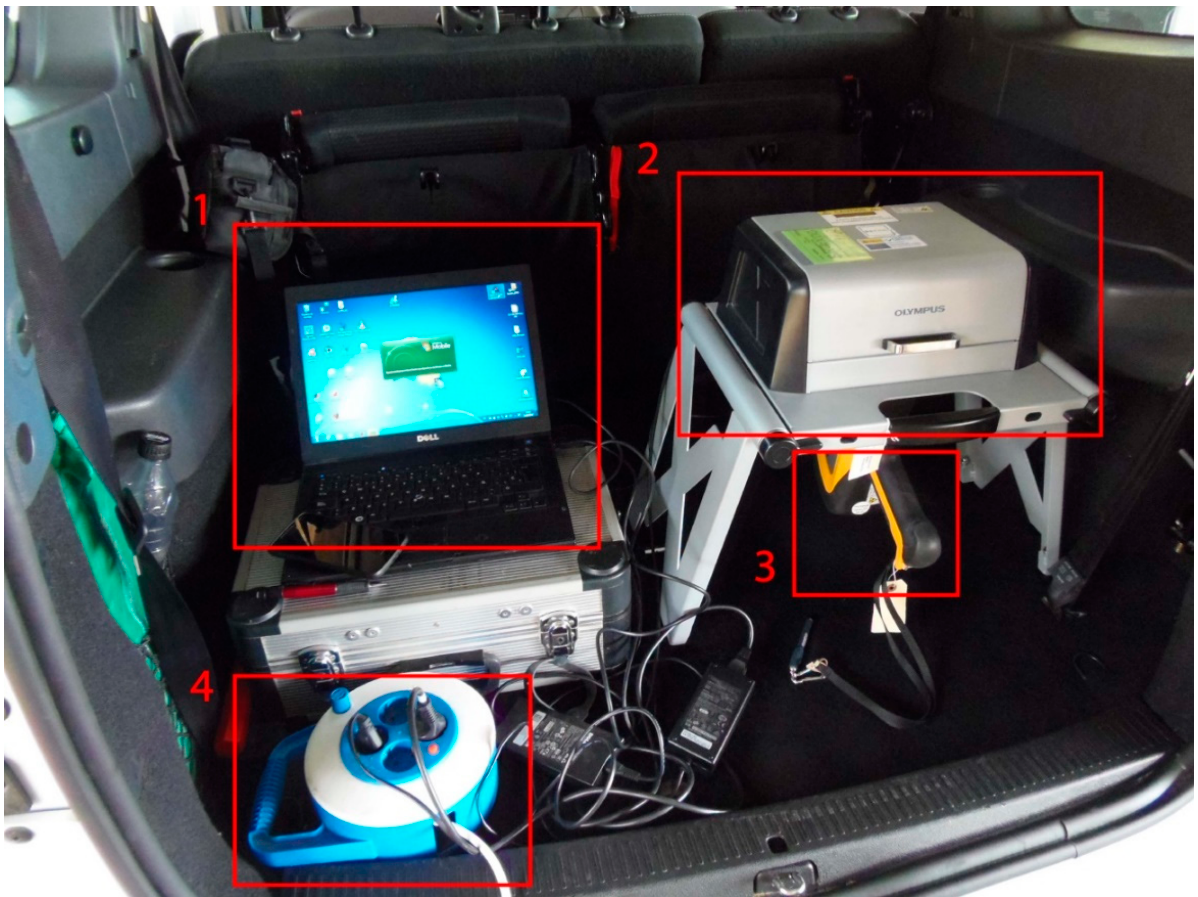
Figure 2. Experimental setup for in-situ chloride analysis. ( 1 ) Laptop computer; ( 2 ) Workbench; ( 3 ) Handheld X-ray fluorescence analyser (hXRF) analyser; ( 4 ) External generator (photo taken by S. Chinchón-Payá).